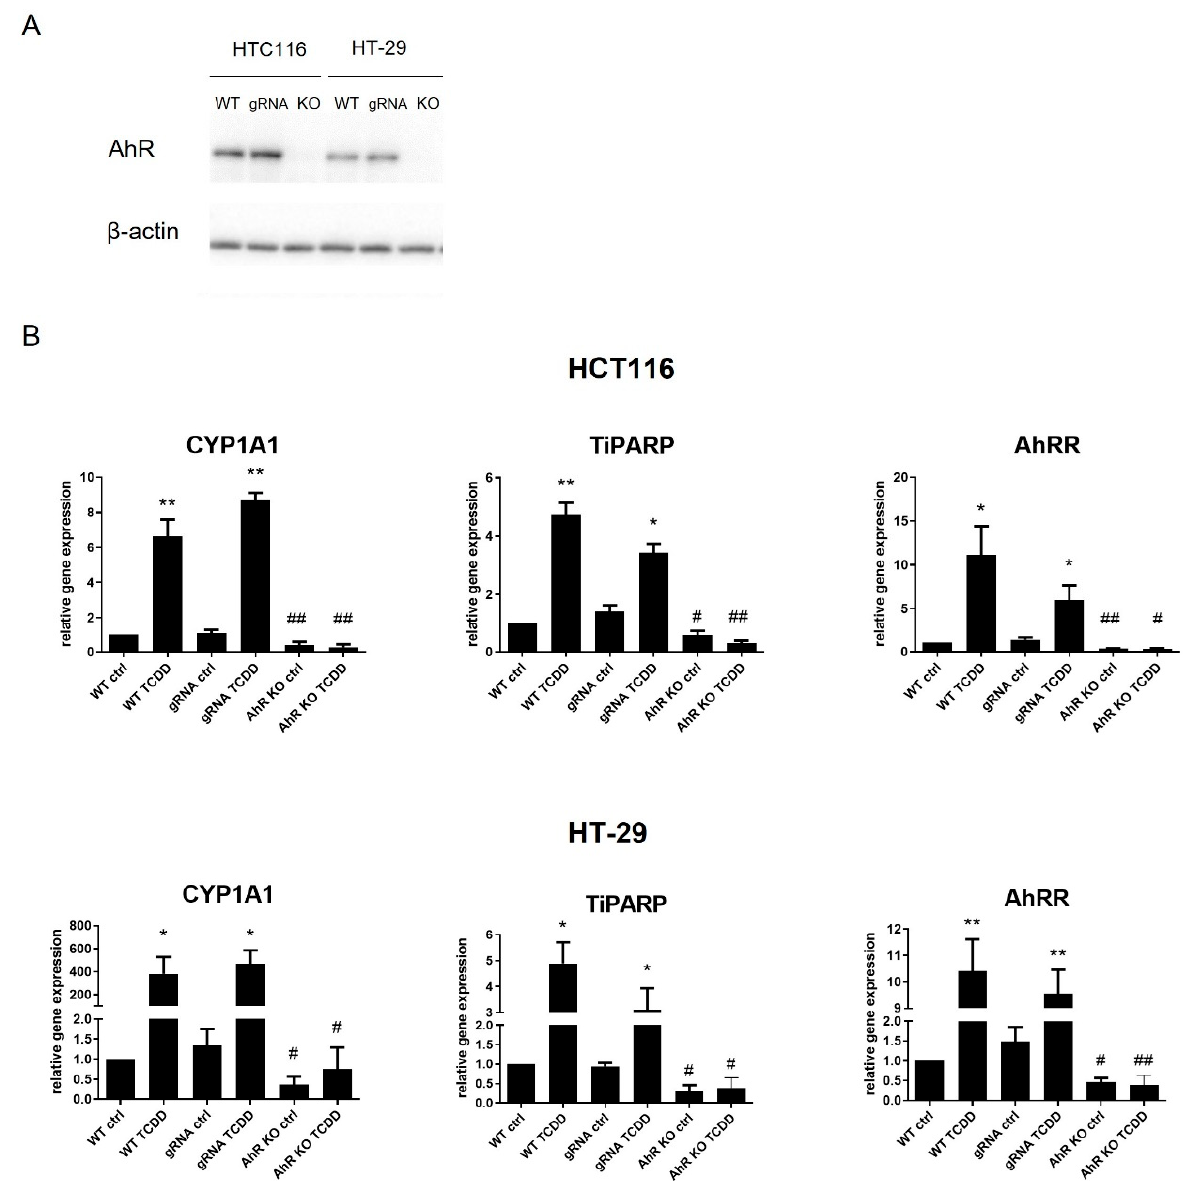
Figure 2. Loss of the AhR blocks induction of its target genes in HT-29 and HCT116 AhR KO cells. ( A ) Wild-type cells (WT), cells transfected with a CRISPR-Cas9 empty vector (gRNA) and AhR KO cell clones of HCT116 and HT-29 were used for detection of the AhR protein levels by Western blotting. For original blots, see Supplementary File S1. ( B ) Induction of AhR-target gene mRNAs after 24 h treatment with TCDD (10 nM) was determined by RT-qPCR. The data are shown as means + SD of at least three independent experiments. * and ** denote a significant difference ( p < 0.05 and p < 0.01, respectively) between TCDD-treated and respective control cells. # and ## denote a significant difference ( p < 0.05 and p < 0.01, respectively) between TCDD-treated AhR KO cells and the respective TCDD-treated wild-type